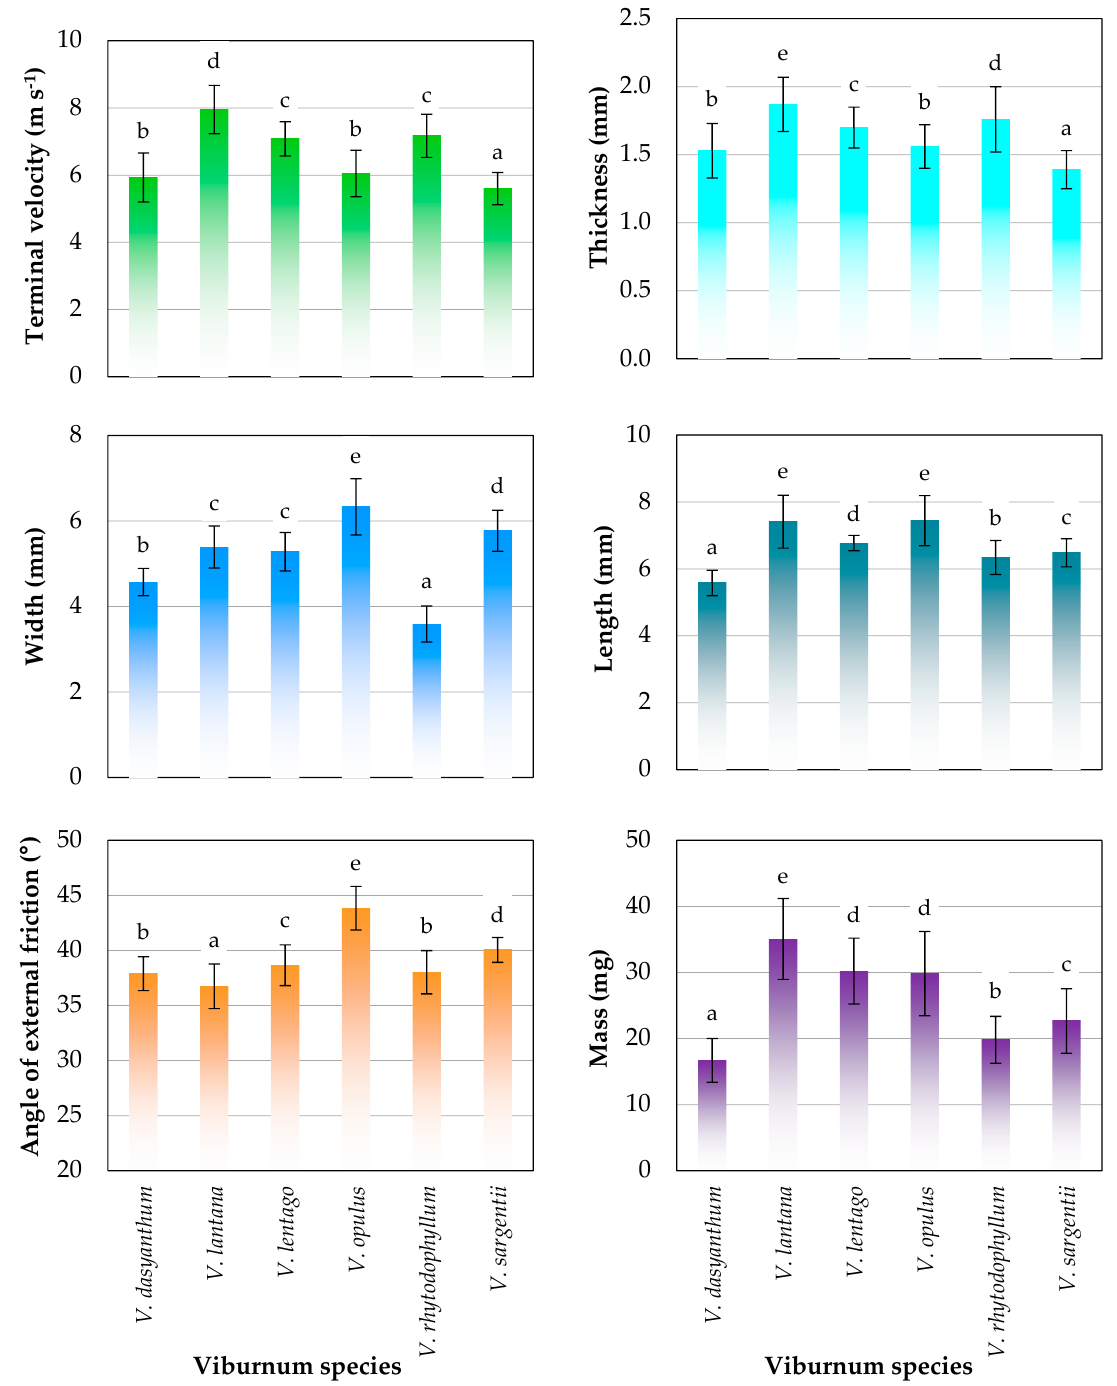
Figure 2. Physical attributes (mean value and standard deviation) of Viburnum seeds and significant differences between Viburnum species. Note: a, b, c, d, e—various letters denote significant differences at p < 0.05 (Duncan’s test). The angle of external friction was relatively large at 31 ◦ ( Viburnum lantana ) to 48